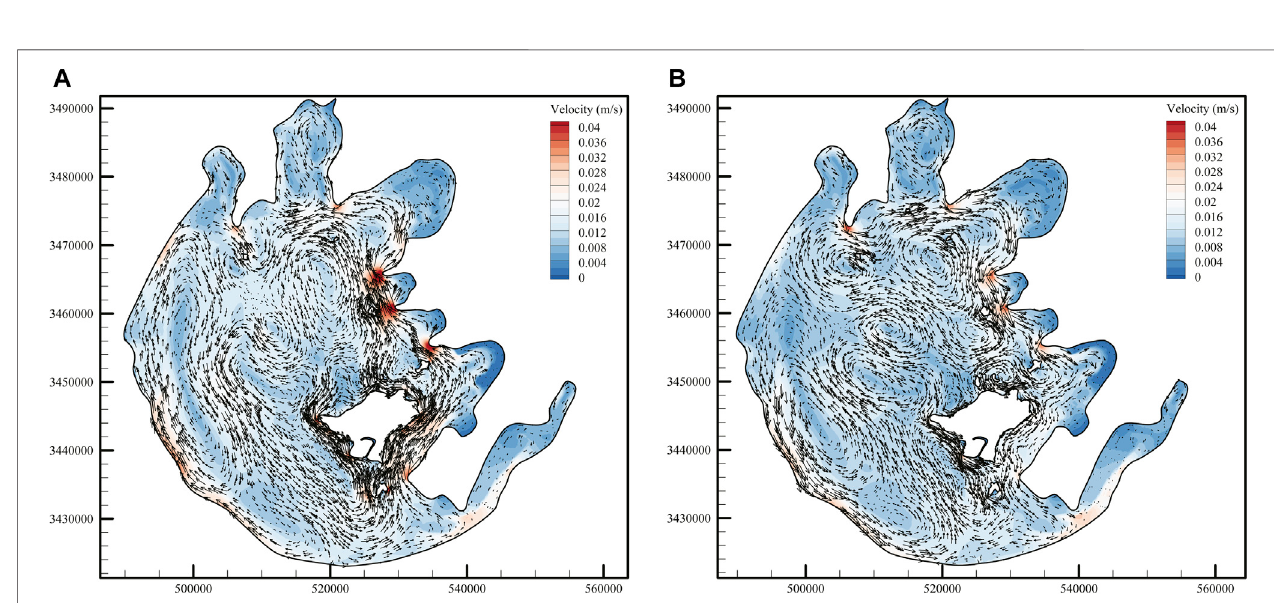
FIGURE 8 | Monthly mean depth-averaged fl ow fi eld with the consideration of vegetation: (A) July and (B) November.